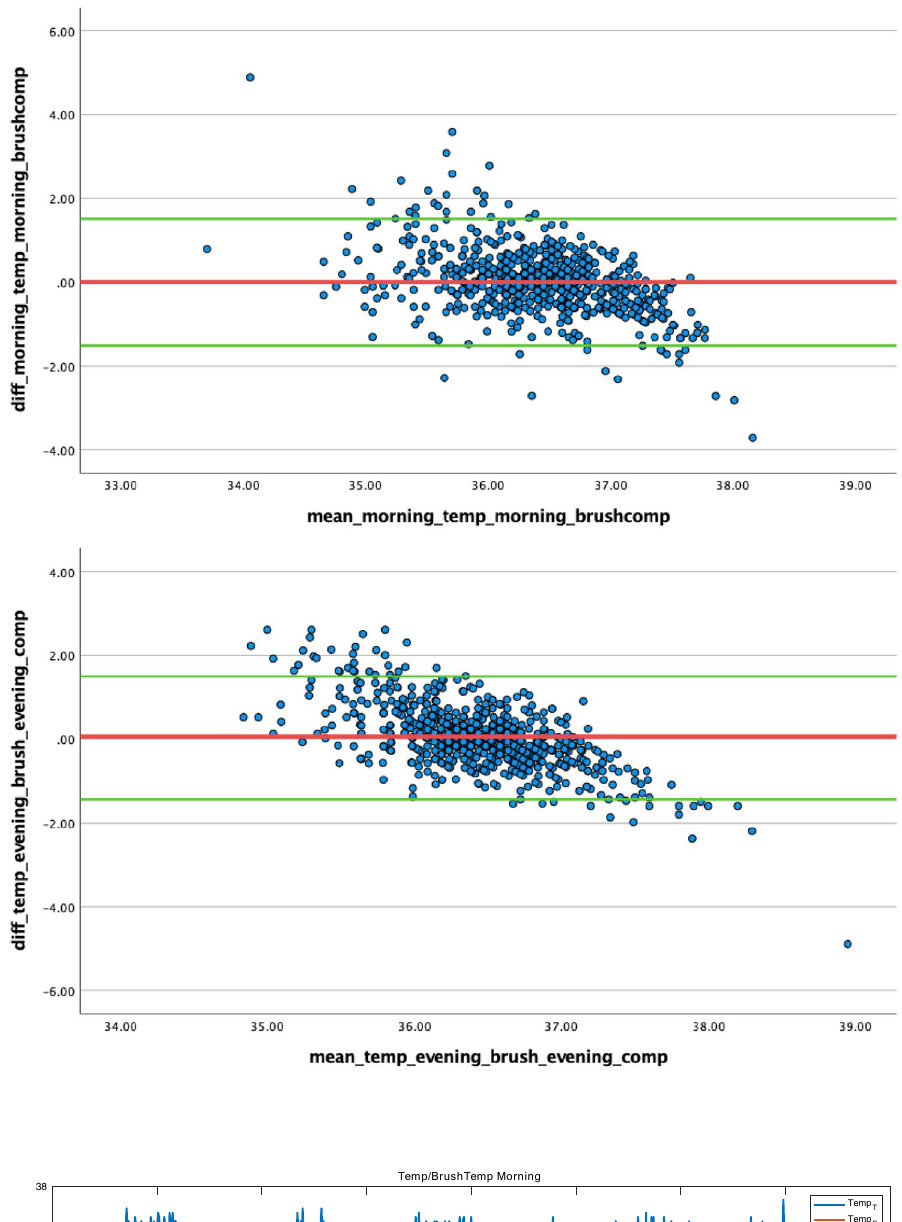
Fig. 4 Bland-Altman plot morning and evening for ID